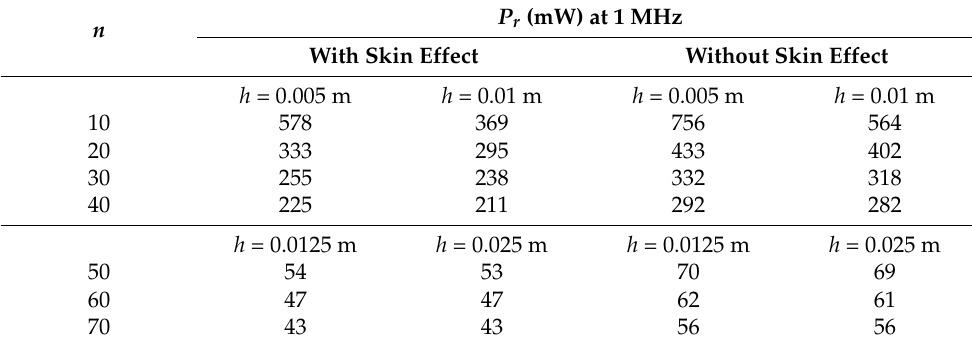
Table 8. Maximum load power values at 1 MHz.